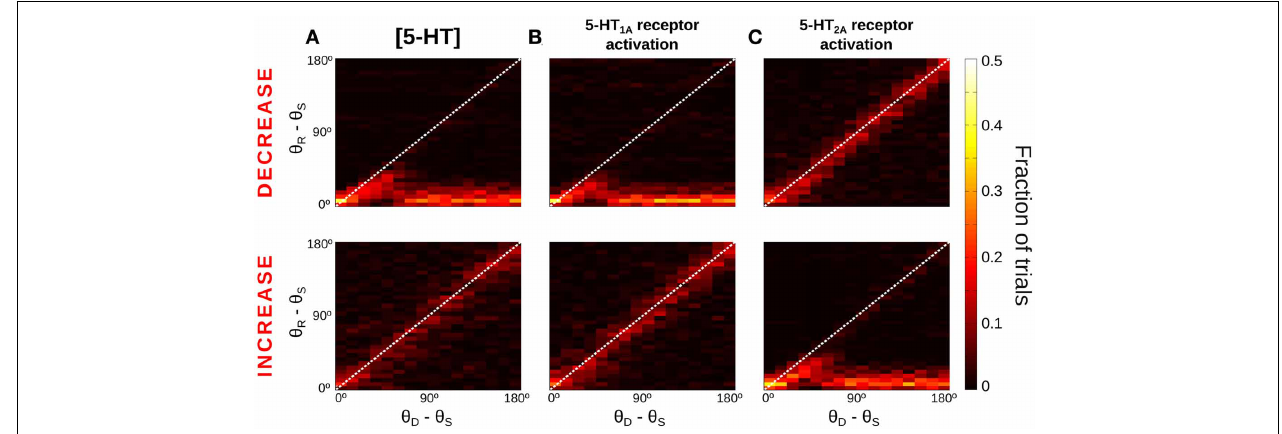
and 5-HT 1A agonists (Bottom, + 10% change relative to baseline 5-HT 1A activation) have similar effects on network distractibility than corresponding manipulations of [5-HT], suggesting that general 5-HT modulation operates primarily on 5-HT 1A receptors. (C) In contrast, 5-HT 2A agonists (Top, + 20% change relative to physiological value) and 5-HT 2A antagonists (Bottom, + 20% change relative to physiological value) follow the opposite trend than corresponding [5-HT]